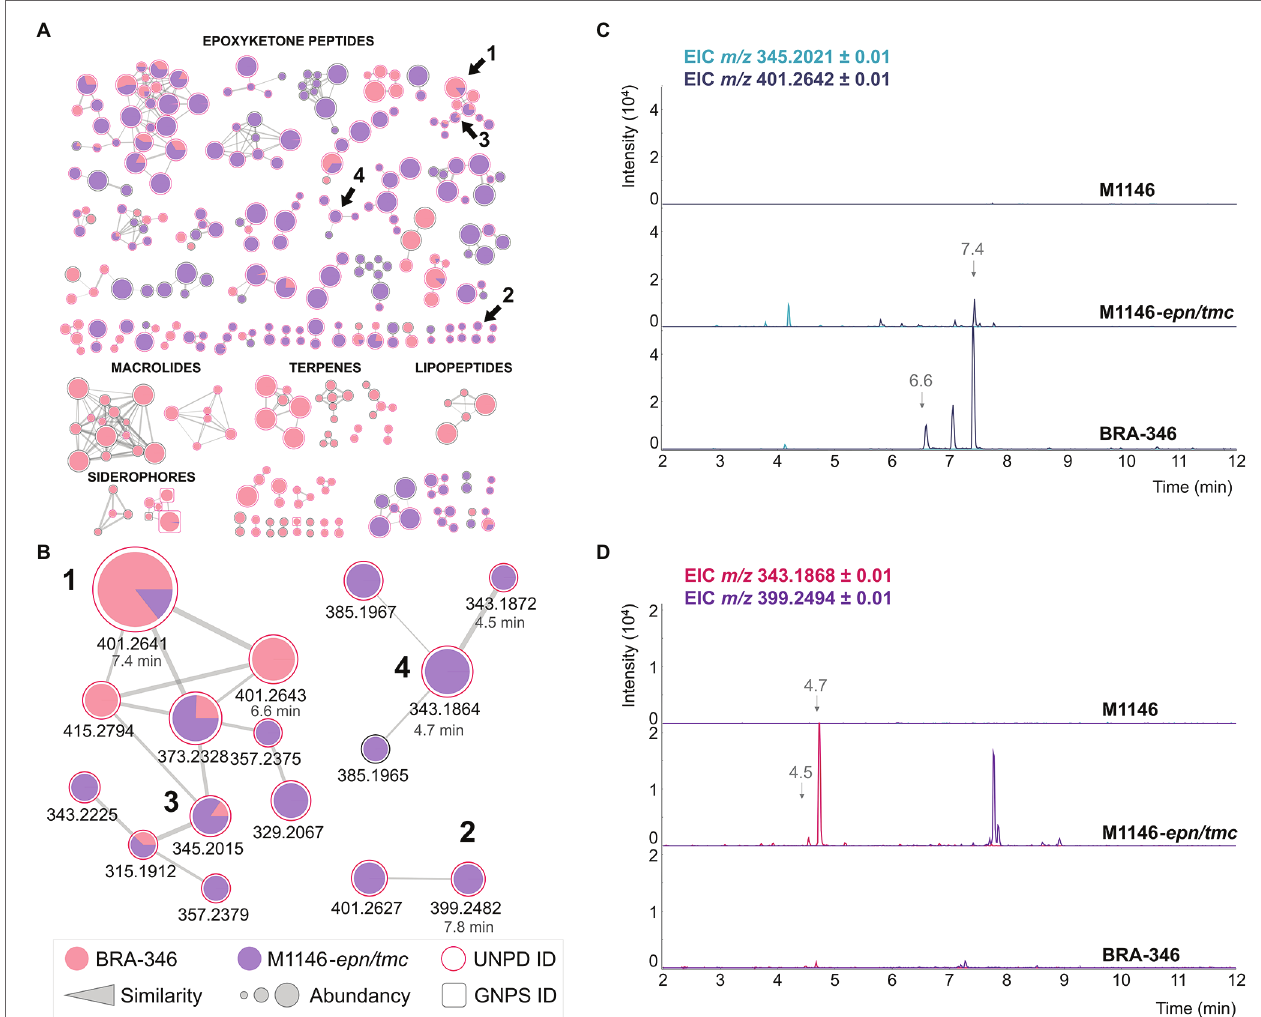
FIGURE 5 | Heterologous expression of the epn/tmc BGC of BRA-346. (A) SSMN evidencing the production of epoxyketone peptides by the heterologous (purple) and the wild type (pink) organisms. (B) Zoom at the SSMN clusters containing compounds 1 – 4 . (C) Extracted ion chromatogram of the dihydrointermediates 1 ( m/z 401.26) and 3 ( m/z 345.20). (D) Extracted ion chromatogram of the final biosynthetic products 2 ( m/z 399.25) and 4 ( m/z